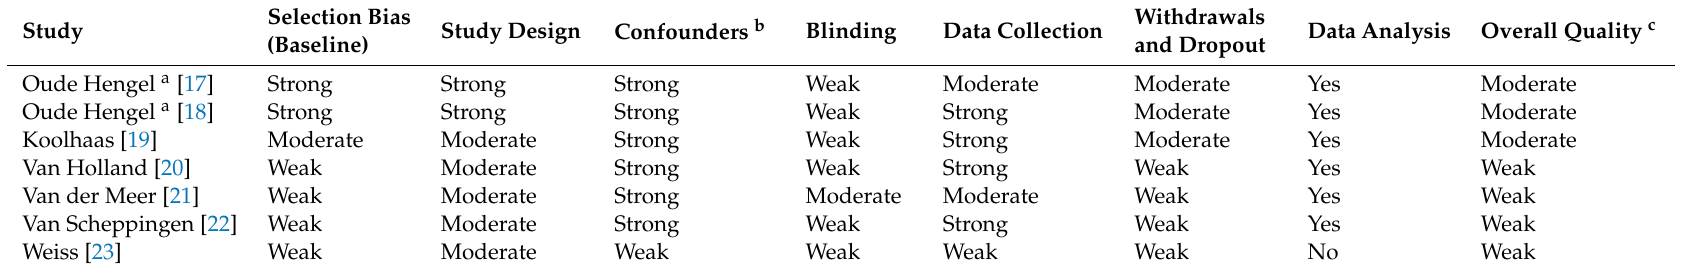
Table 2. Methodological quality of the studies